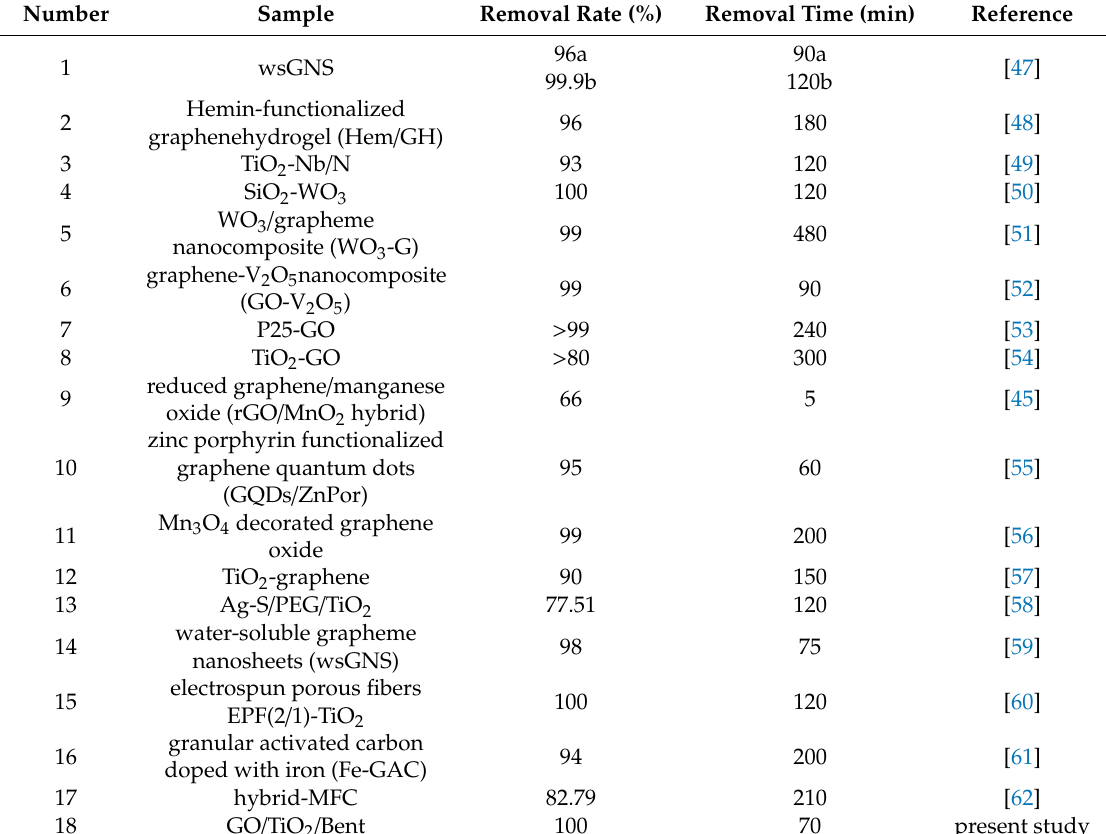
Table 1. The removal rate of MB by various